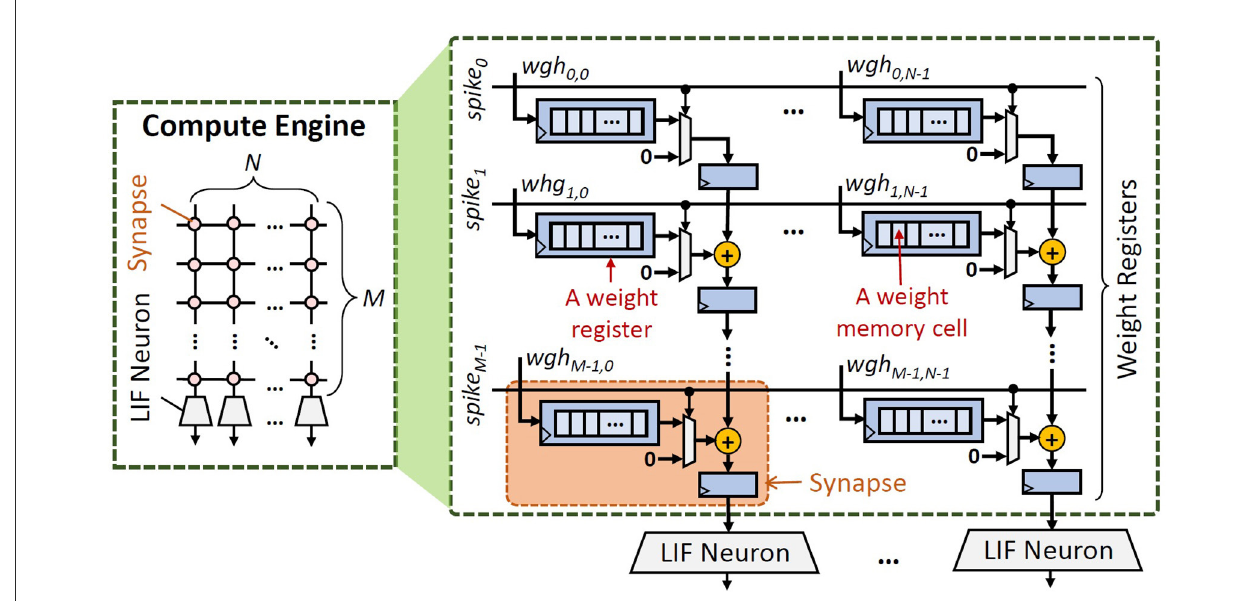
FIGURE4 The architecture of the compute engine of SNN accelerators.